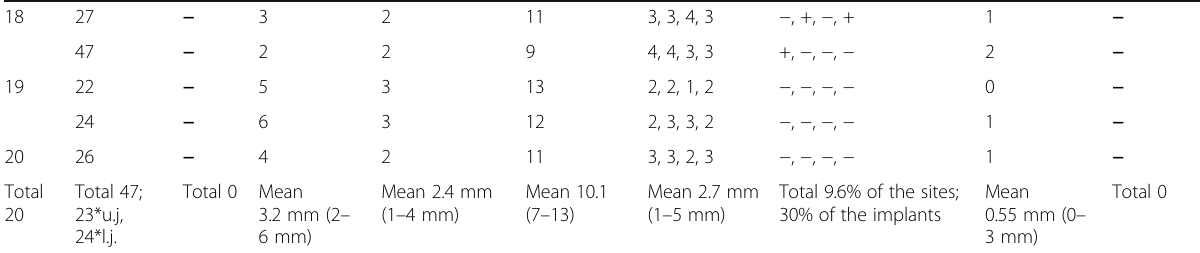
Table 2 Results from the clinical and radiological 3-year follow-up investigation (Continued)